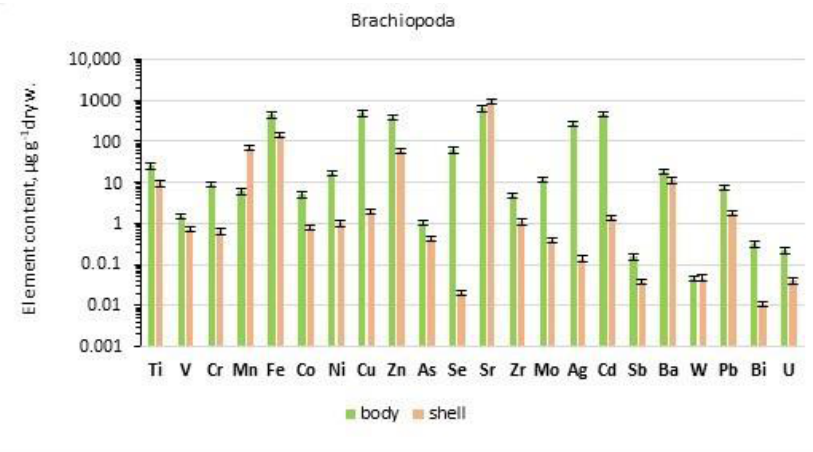
Figure 5. Distribution of the average element concentrations in the Brachiopoda body soft tissues and shell.